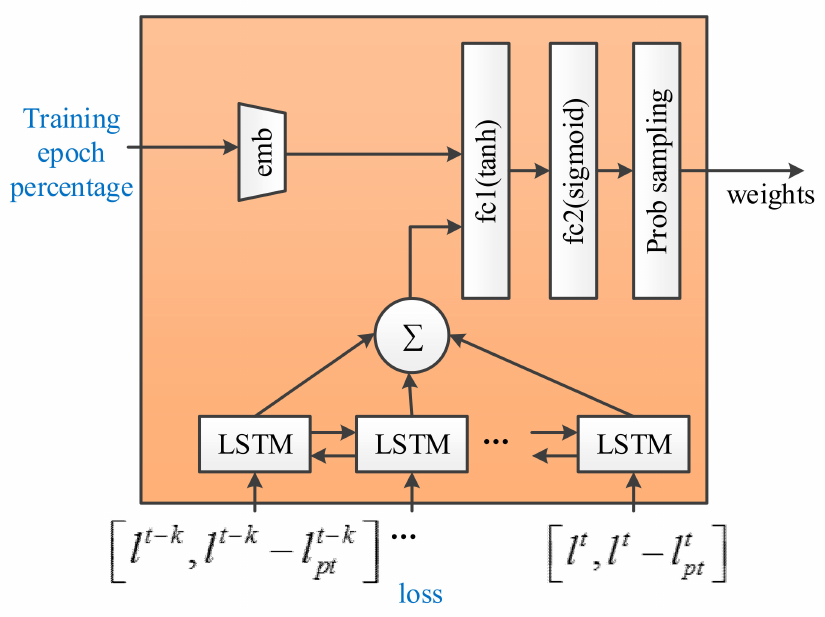
Figure 3. MentorNet